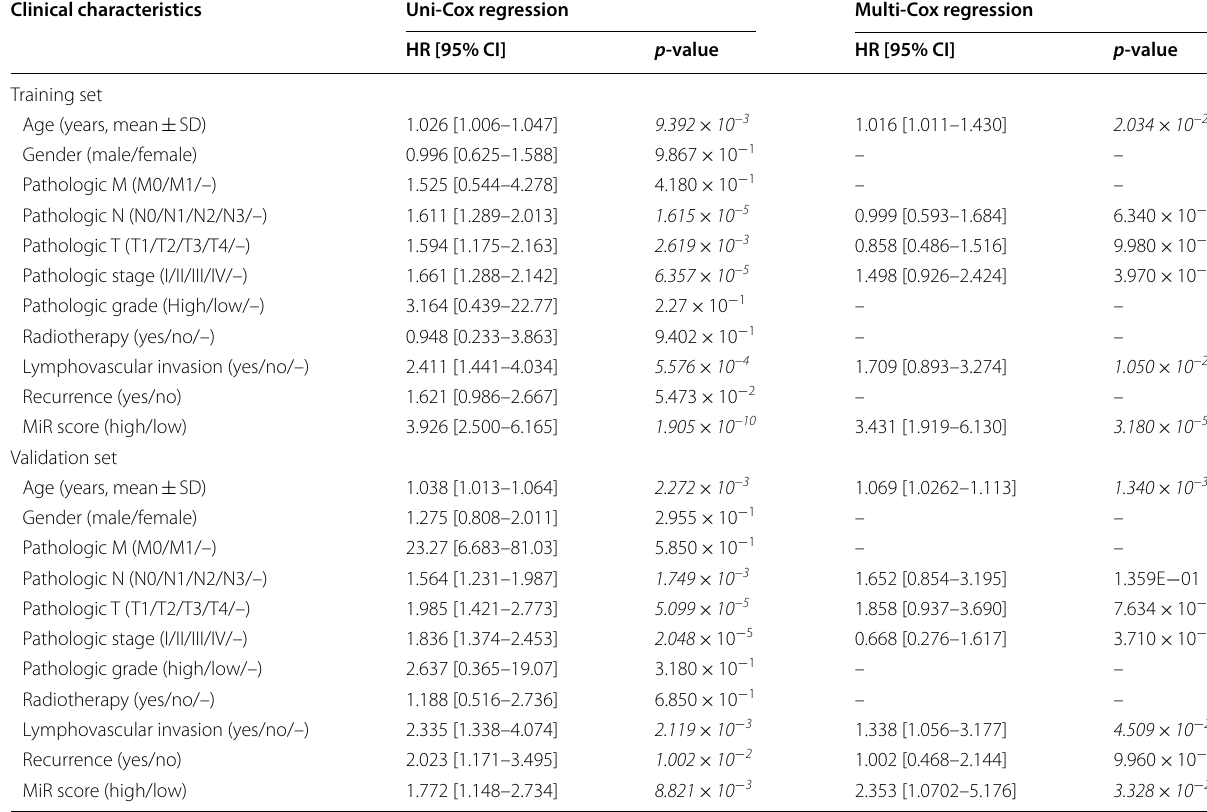
Table 3 Univariate and multivariate Cox Regression analysis of tumor samples in the training set and validation set